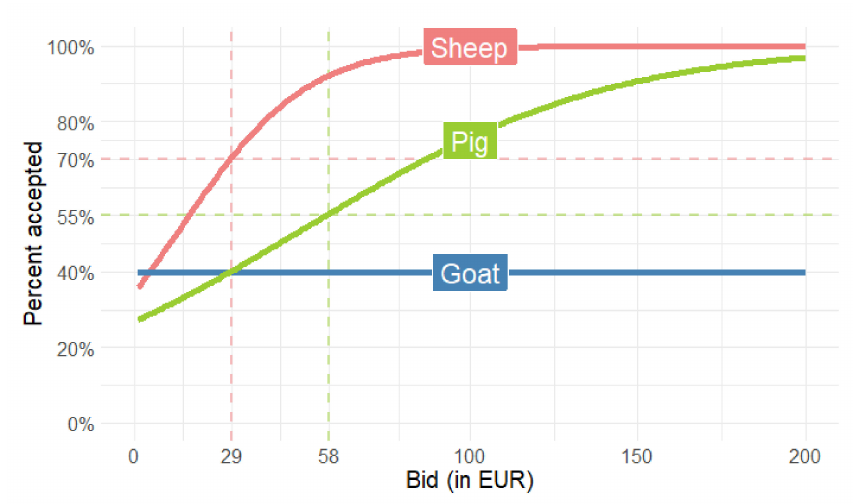
Figure 2. Farmers’ estimated participation in support schemes by payment